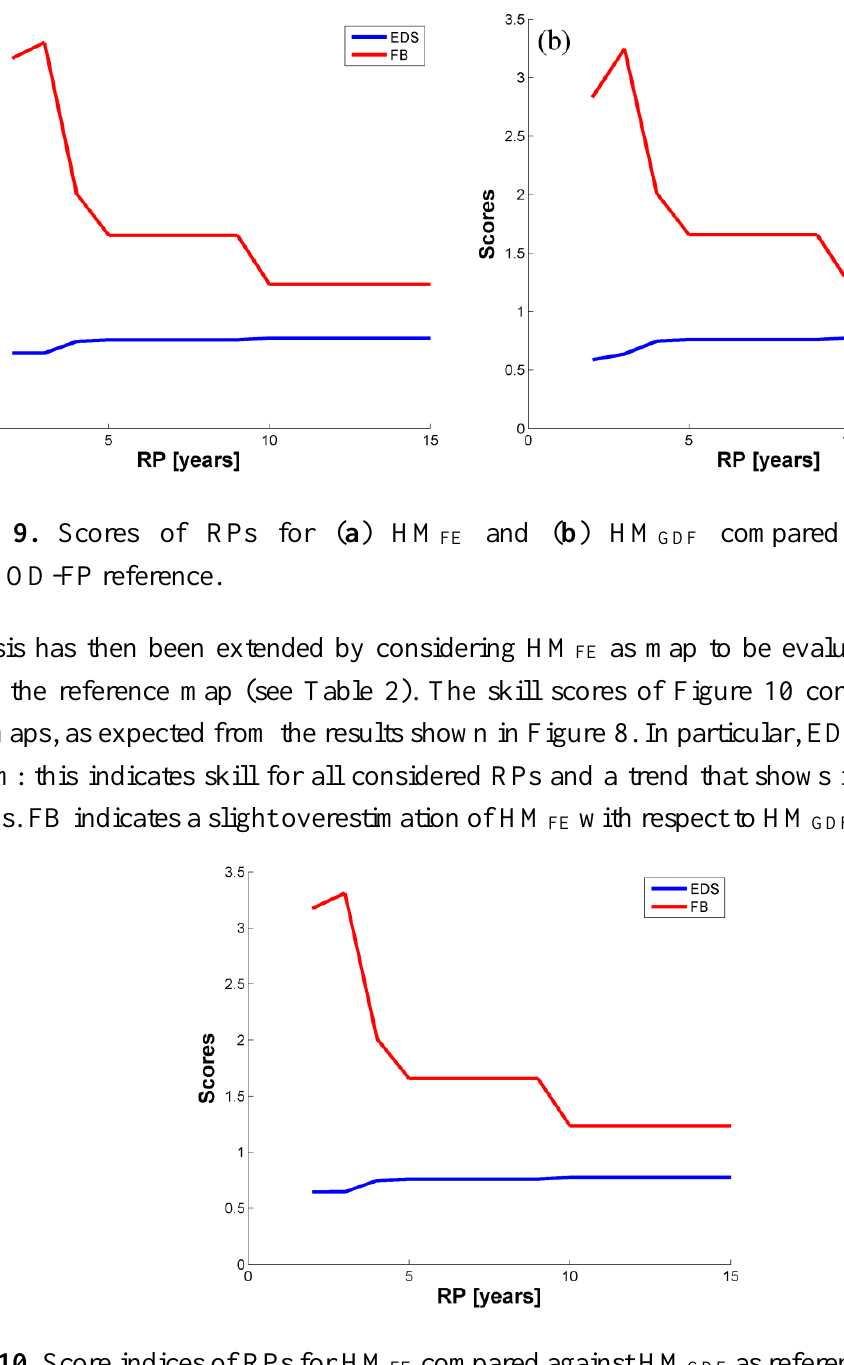
Figure 10. Score indices of RPs for HM FE compared against HM GDF as